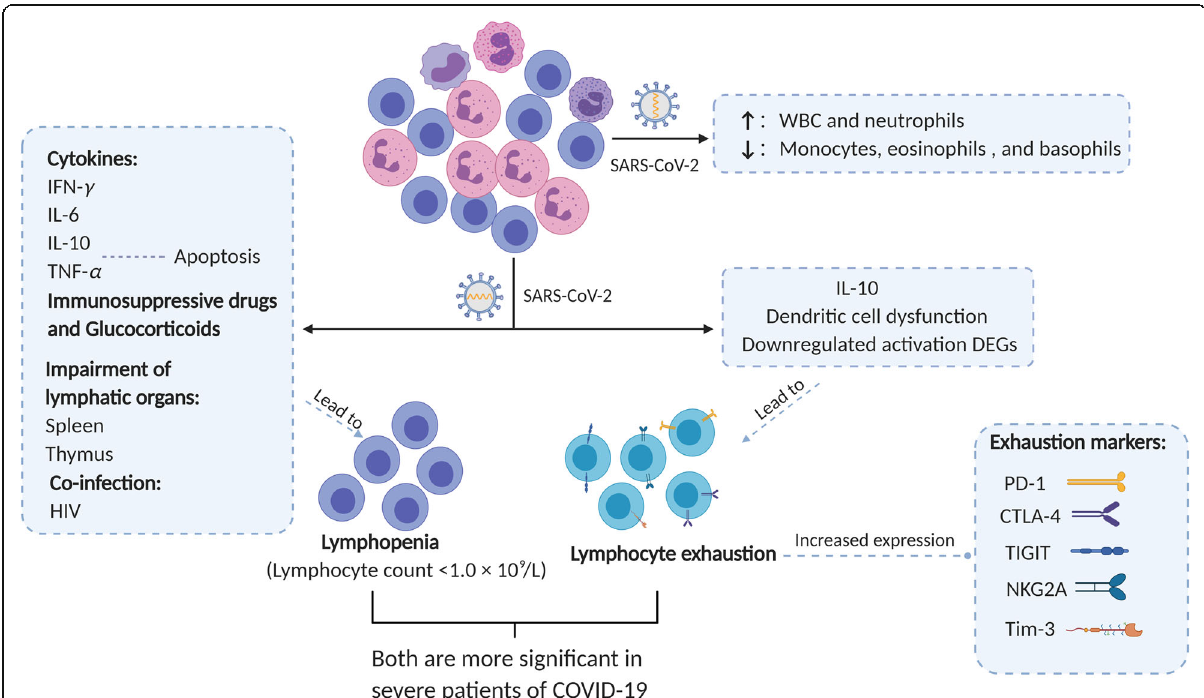
Fig. 1 Immune responses of lymphocytes to SARS-CoV-2 infection. Lymphopenia and lymphocyte exhaustion are two important characteristics of SARS-CoV-2 infection, which are aggravated in severe patients of COVID-19 compared to milder cases. Lymphopenia may result from dysregulated cytokine release (including IFN- γ , IL-6, IL-10, TNF- α ), administration of immunosuppressive drugs or glucocorticoids, impairment of lymphatic organs (i.e. spleen and thymus), and co-infection with HIV. TNF- α leads to lymphopenia by inducing cell apoptosis. Increased level of IL-10, virus-induced dendritic cell dysfunction and down-regulated differentially expressed genes (DEGs) involved in T cell activation are major causes of T cell exhaustion in COVID-19 patients. Lymphocyte exhaustion is featured by increased expression of exhaustion markers including PD-1, CTLA-4, NKG2A, TIGIT and Tim-3. WBC and neutrophils are continuously increased after SARS-CoV-2 infection while monocytes, eosinophils, and basophils could be